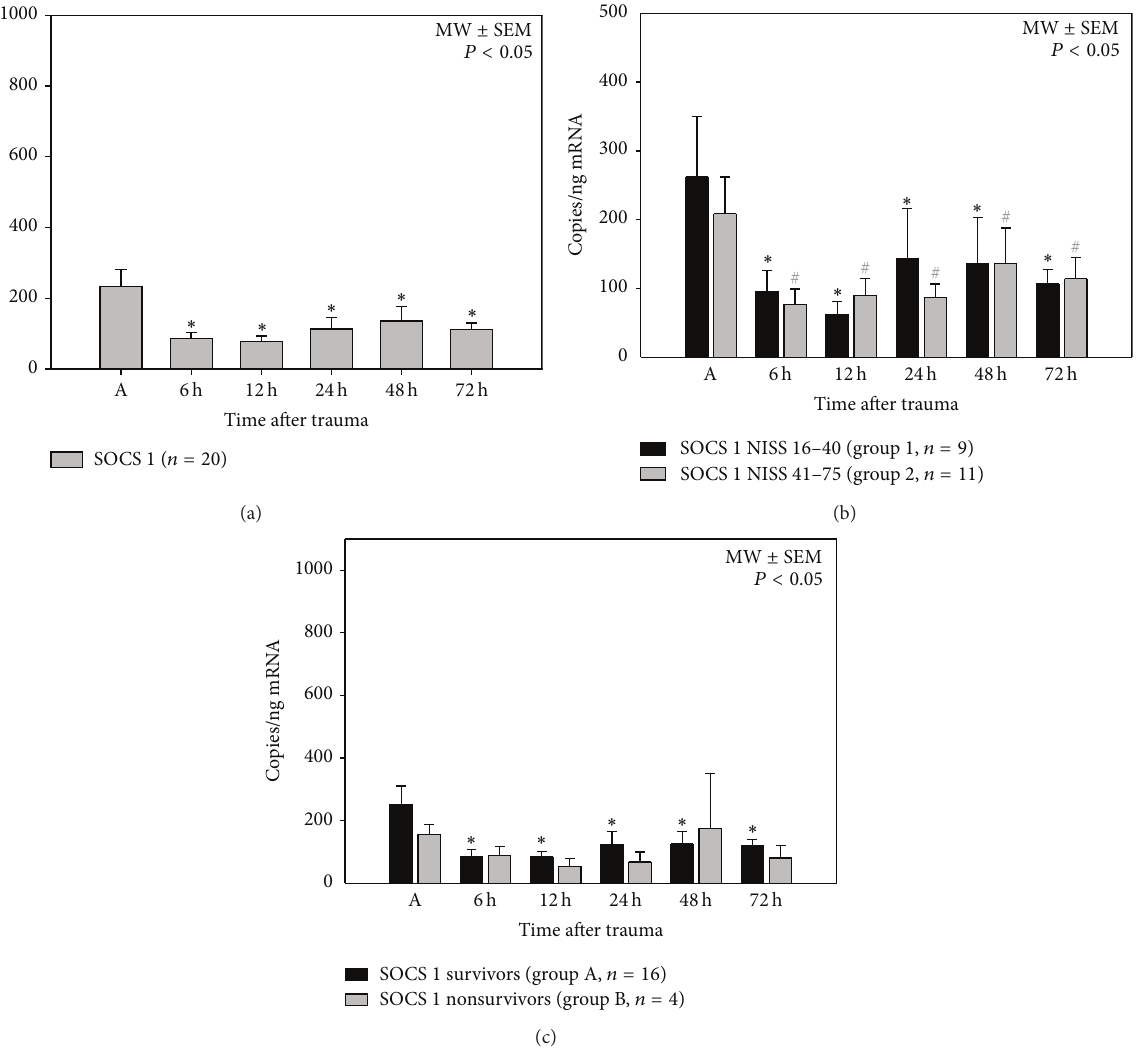
Figure 3: Posttraumatic SOCS 1 mRNA expression profiles after major trauma in all patients (a), depending on injury severity (NISS, (b)) and depending on outcome (survival > 90 days, (c)), ∗ 𝑃 < 0.05 SNK-test, # 𝑃 < 0.05 U test. SOCS 1 mRNA expression levels significantly decreased after 6h–72 h compared to SOCS 1 levels measured on admission (A). SOCS 1 mRNA levels of both subgroups (groups 1 and 2) decreased significantly in the early posttraumatic period (6h–72) compared to SOCS 1 levels on admission (A). There was no significant difference between the subgroups (group 1/group 2). SOCS 1 mRNA levels significantly decreased in survivors (group A) in the posttraumatic observation period (6h–72 h) in comparison to SOCS 1 mRNA expression detected on admission